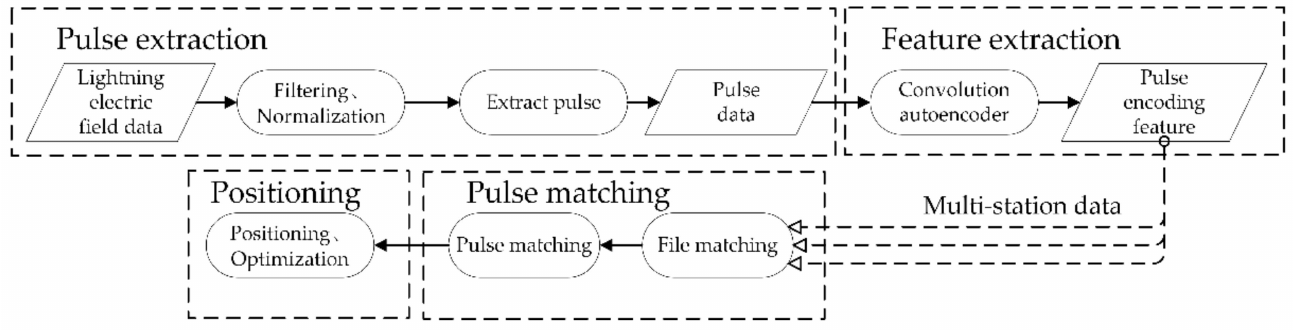
Figure 4. Schematic of the new